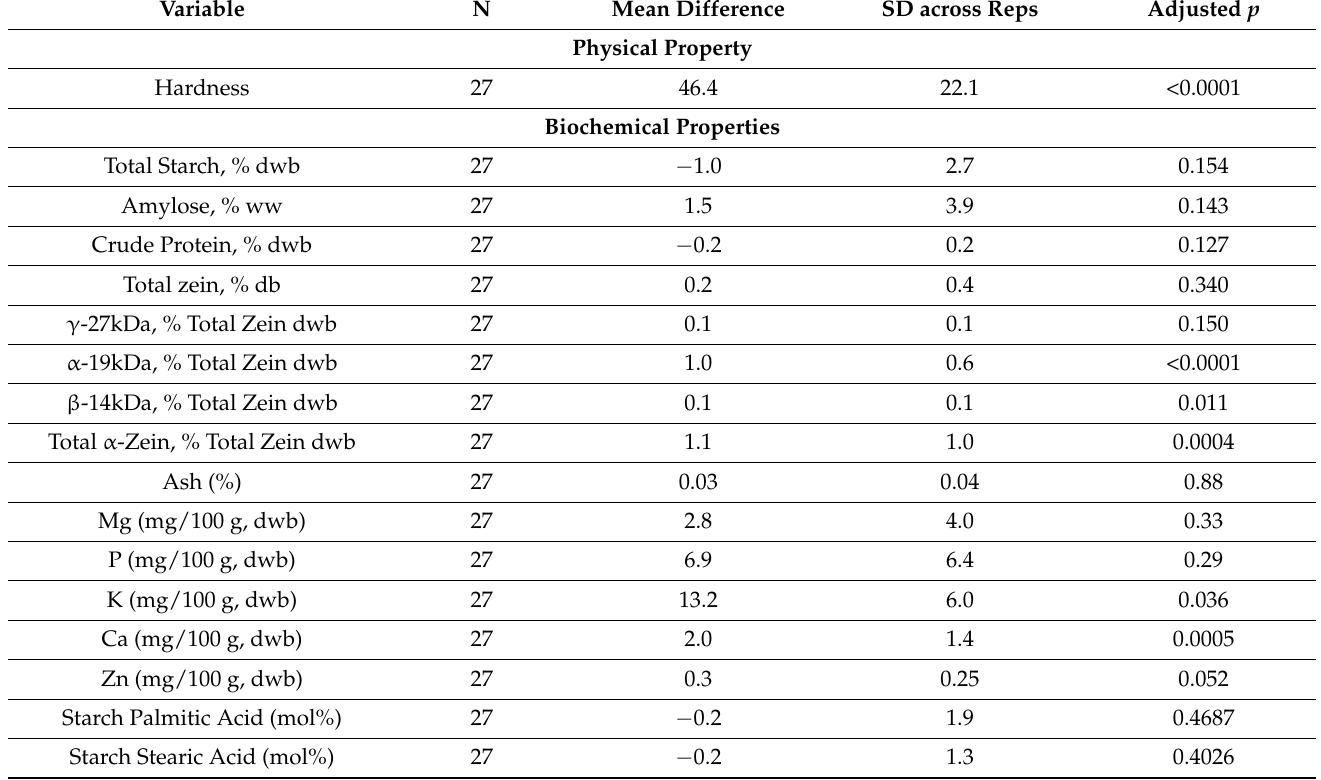
Table 3. Differences between flint and dent kernel types in physical and chemical